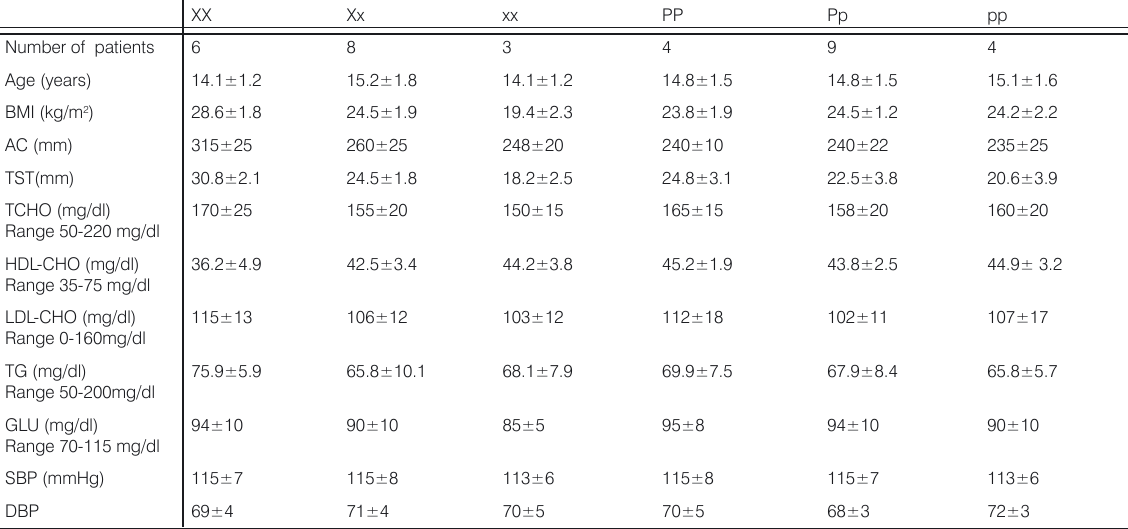
Table 3. Anthropometric, metabolic and blood pressure values in female teen-agers with Down Syndrome belonging to various ER